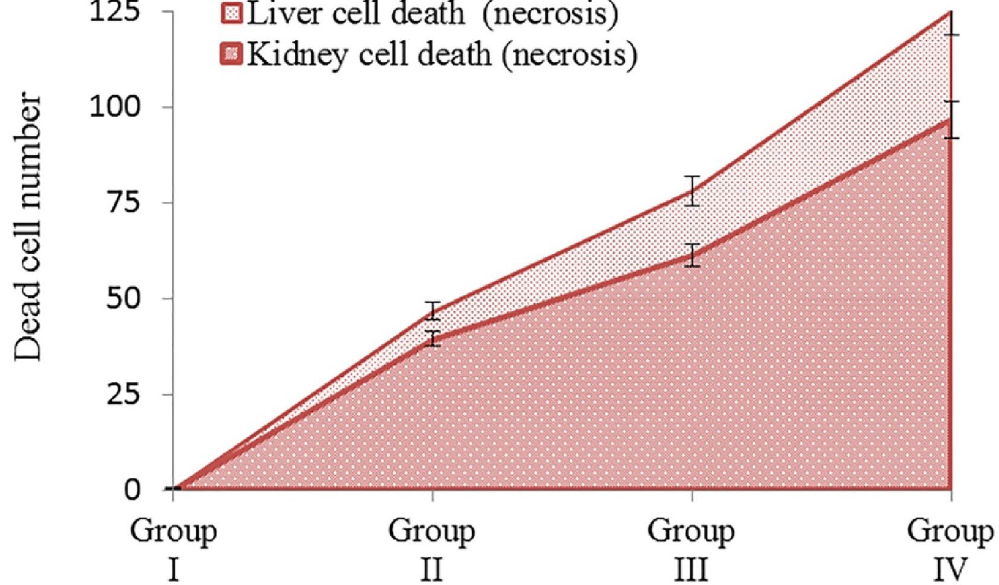
Figure 3. Cell death induced by cypermethrin in liver and kidney cells. *Group I: control, Group II: 62.5 mg/kg b.w cypermethrin, Group III: 125 mg/kg b.w cypermethrin, Group IV: 250 mg/kg b.w cypermethrin. 100 cells were counted for each mouse in each group, a total of 600 cells. Values are shown as mean ± SEM (n =